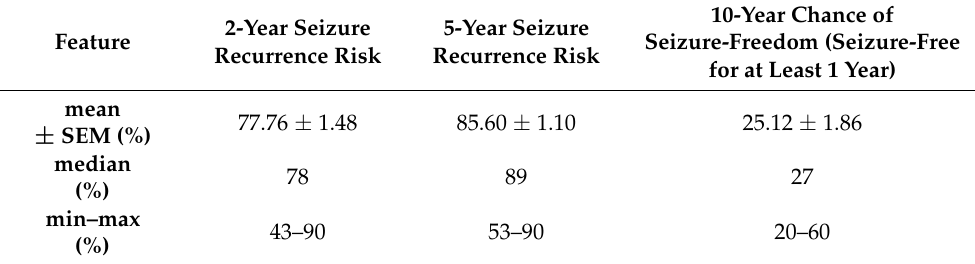
Table 7. Clinical characteristics of the patients–prediction of seizure recurrence as assessed with EPT.